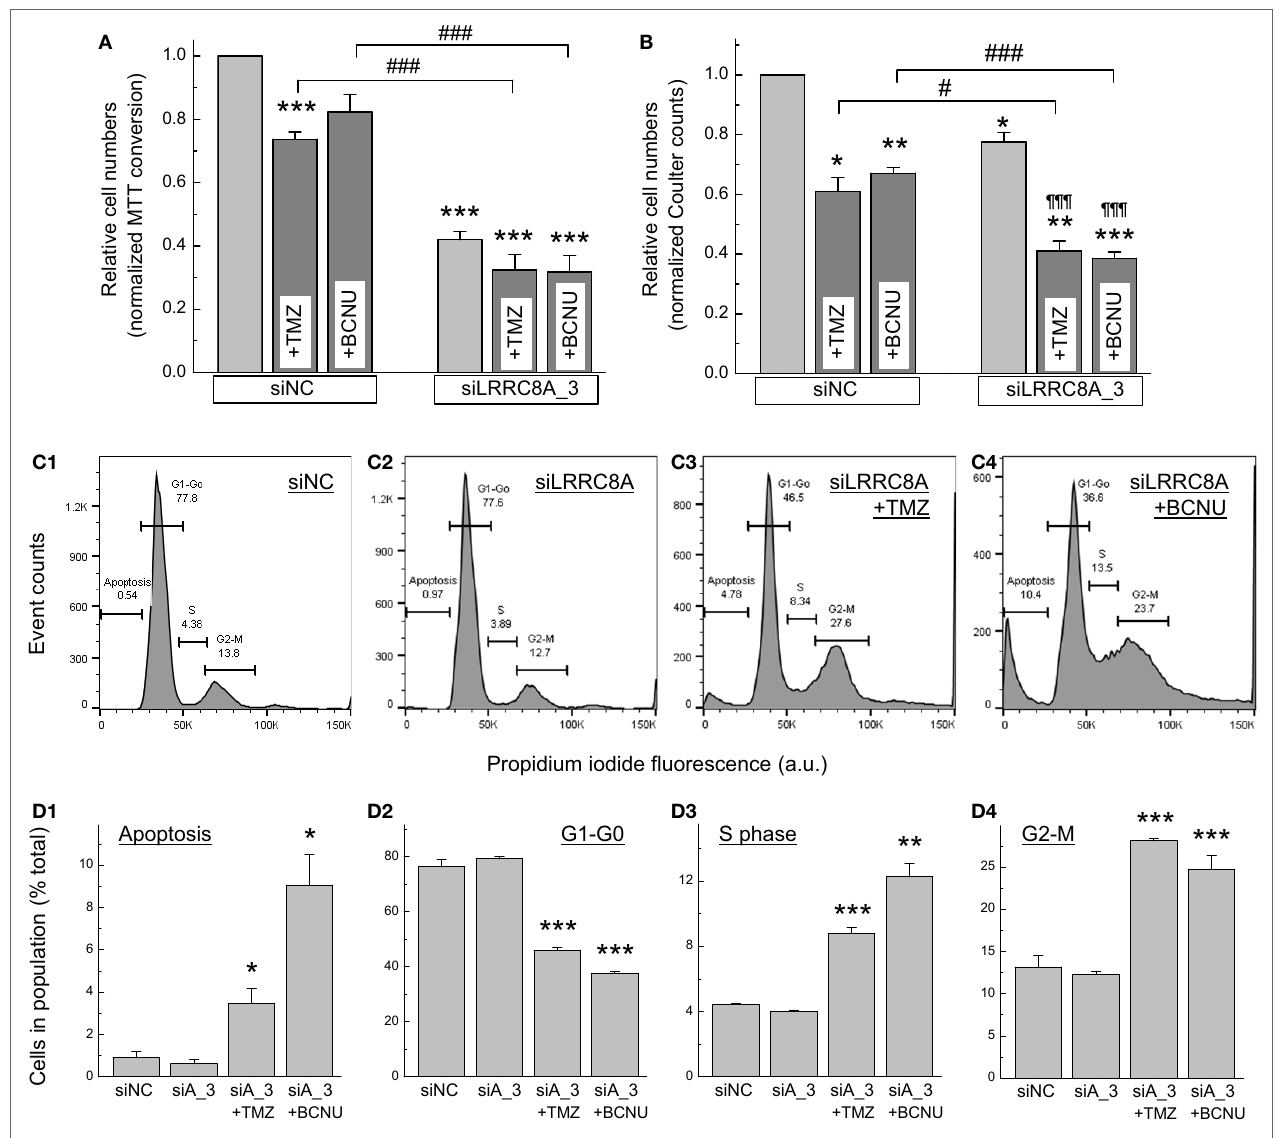
FigUre 7 | Effects of temozolomide (TMZ), carmustine [bis-chloroethylnitrosourea (BCNU)], and leucine-rich repeat-containing 8A (LRRC8A) siRNA on viability and proliferation of U251 cells determined using 3-(4,5-dimethylthiazol-2-yl)-2,5-diphenyl tetrazolium bromide (MTT) (a) and Coulter counter (B) assays, and fluorescence-assisted cell sorting (FACS) analysis (c,D) . U251 cells were transfected with siLRRC8A_3 (siLRRC8A or siA_3) or negative control siRNA (siNC). 48 h post-transfection they were additionally treated with 570 µM TMZ or 57 µM BCNU. Viability assays were performed 48 h after addition of chemotherapeutic agents (96 h post-transfection with siRNA). Representative FACS data are shown in the fields c1–c4 , and their quantitation in D1–D4 . The data are the mean values ± SE of (a) 10–12 independent MTT assays in three independently transfected U251 cell cultures, (b) four Coulter counter assays, and (c) three FACS analyses performed in independently transfected U251 samples. * p < 0.05, ** p < 0.01, *** p < 0.001, vs. cells transfected with siNC. ¶¶¶ p < 0.001, within the group effect of chemotherapeutics. # p < 0.05, ### p < 0.001, the chemotherapeutics effects in cells treated with siNC vs. cells treated with